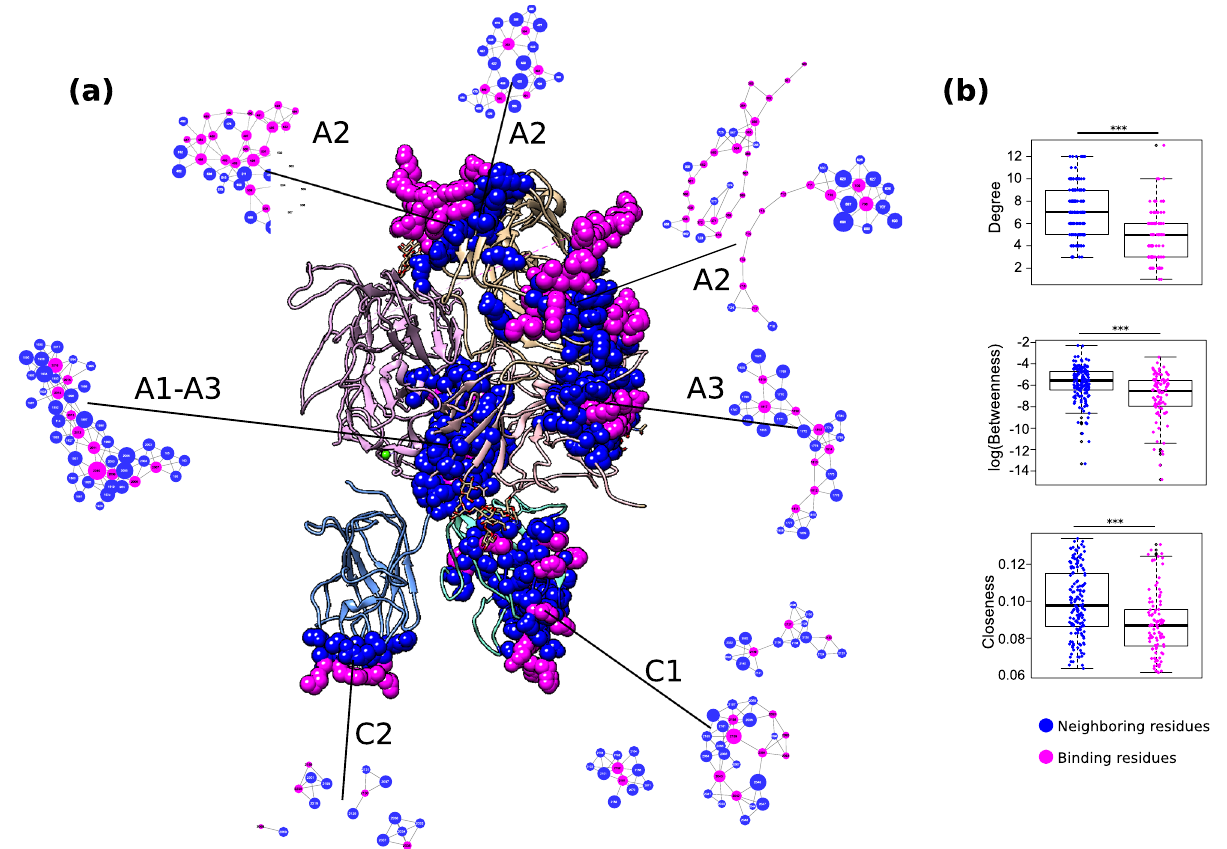
Figure 5. FVIII binding sites and neighboring residues. ( a ) Location of known FVIII binding sites (pink) and their immediate neighboring residues (blue) in the FVIII structure and in the RIN. Image created using the structure 2R7E (Ref. 3 ) and Chimera 1.14 (Ref. 62 ). ( b ) Comparison of the centrality measures of the